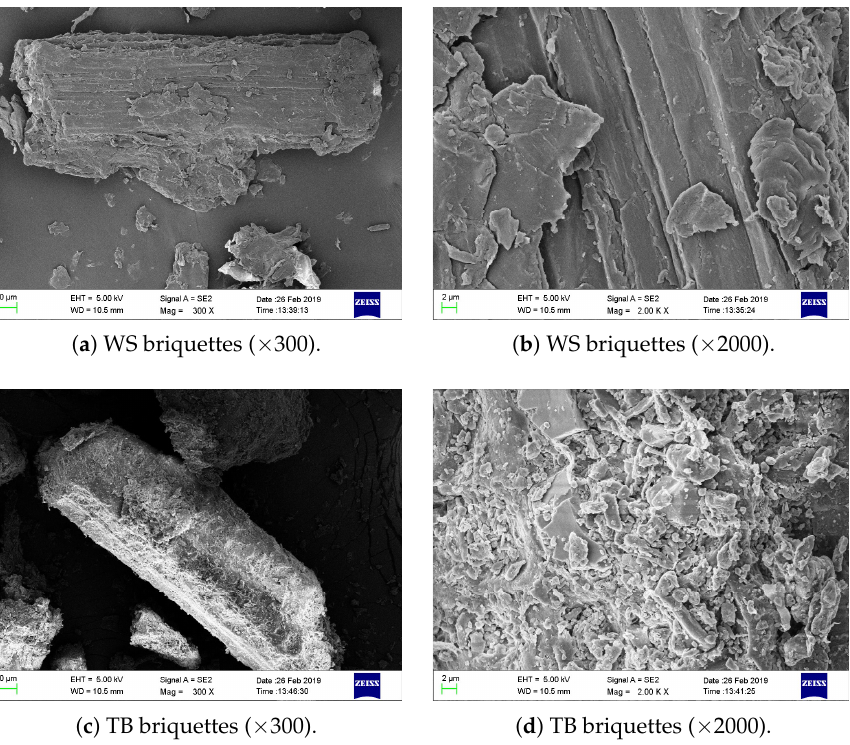
Figure 5. Scanning Electron Microscope (SEM) micrographs of formed